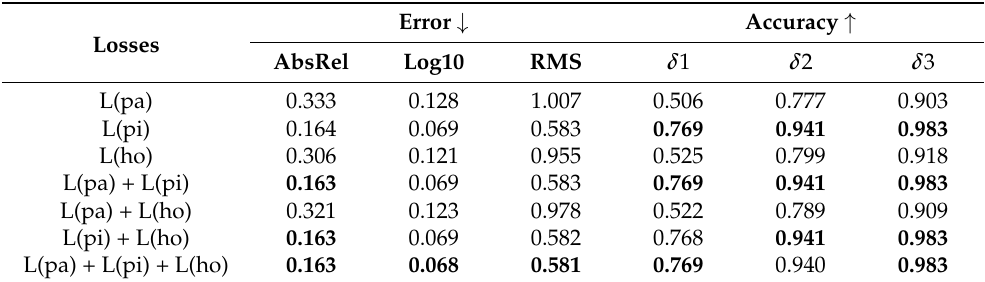
Table 2. Ablation study of baseline.